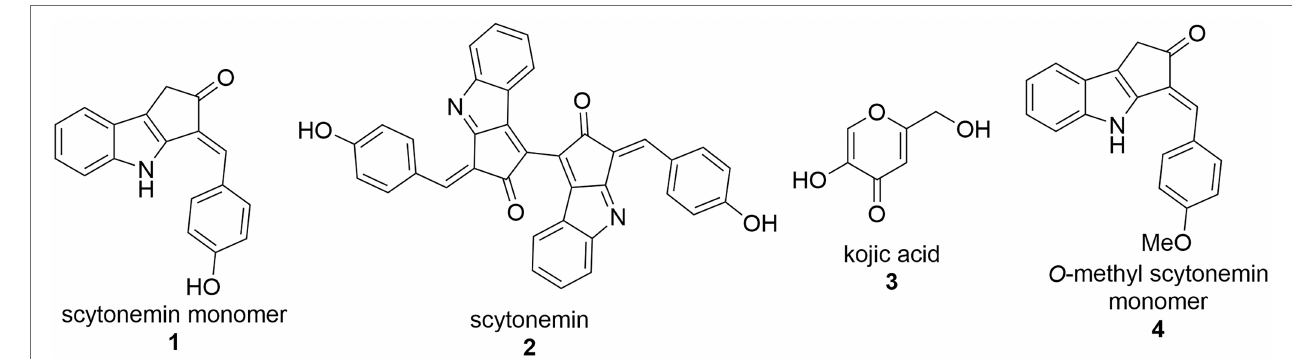
FIGURE 2 | The structures of compounds 1 – 4